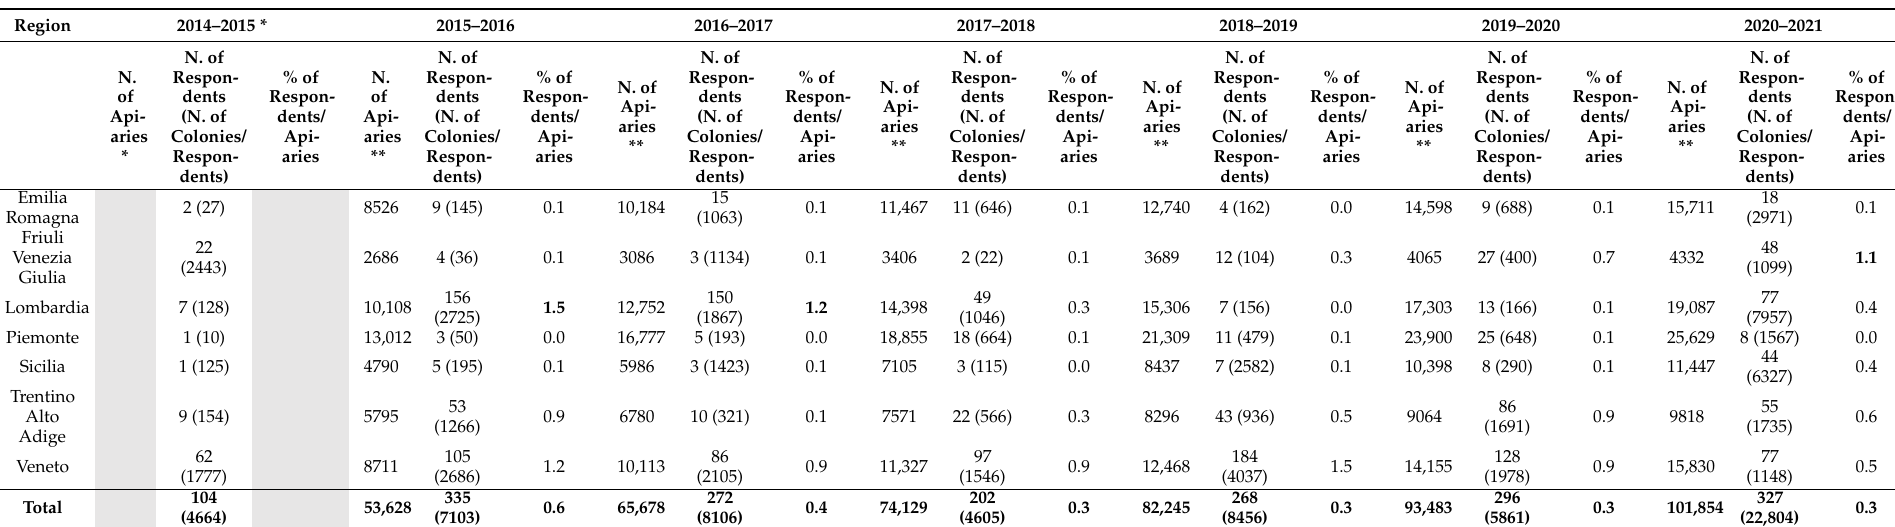
Table 1. Distributions of apiaries by region and year and of respondents with their colonies, along with the percentages of respondents compared to the numbers of apiaries extracted from the Italian national beekeeping